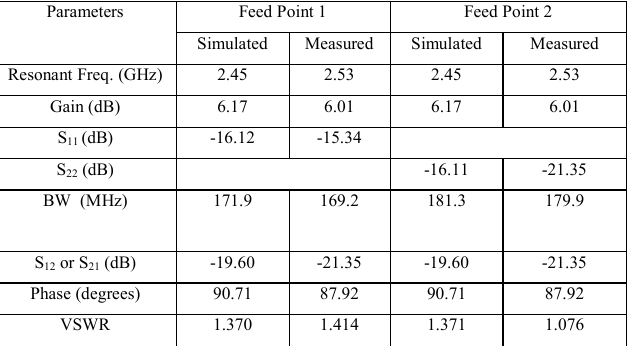
Table 6: Comparision of proposed antenna parameters